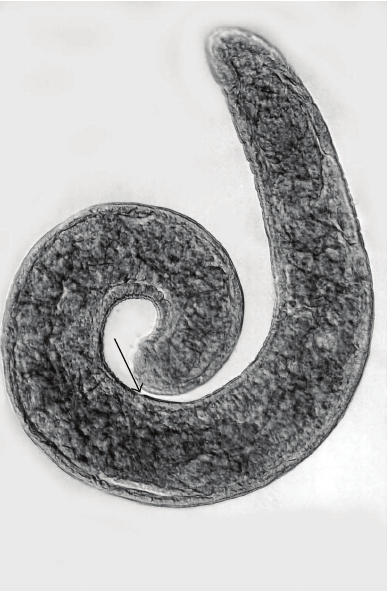
Figure 9: Mature female of Myrmeconema neotropicum in the early stages of egg production removed from a pupa of Cephalotes atratus . Arrow shows position of vulva.